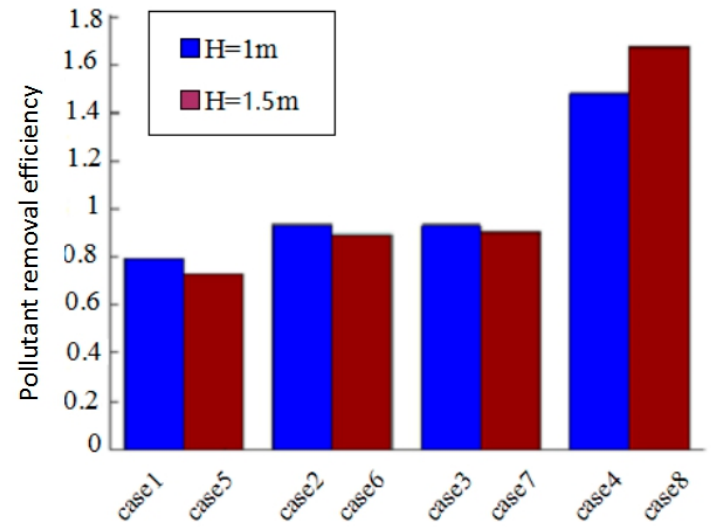
Figure 11. Pollutant removal efficiency under different scenarios.